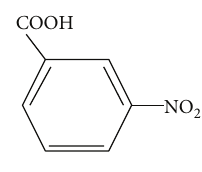
Figure 12: Structure of nitrobenzoic acid (NBA).